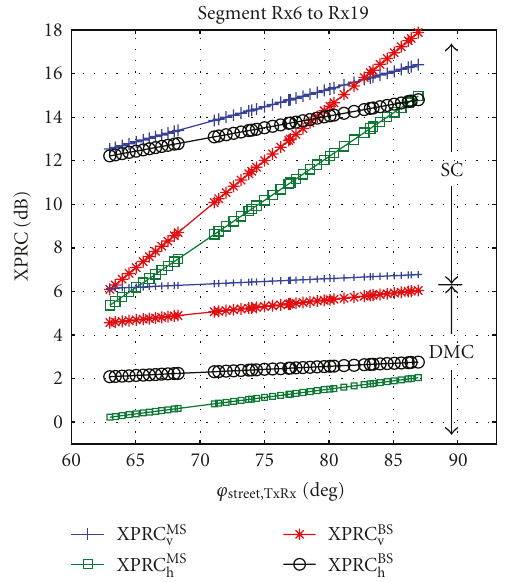
Figure 9: Change of the XPRCs dependent on the angle ϕ street,TxRx .